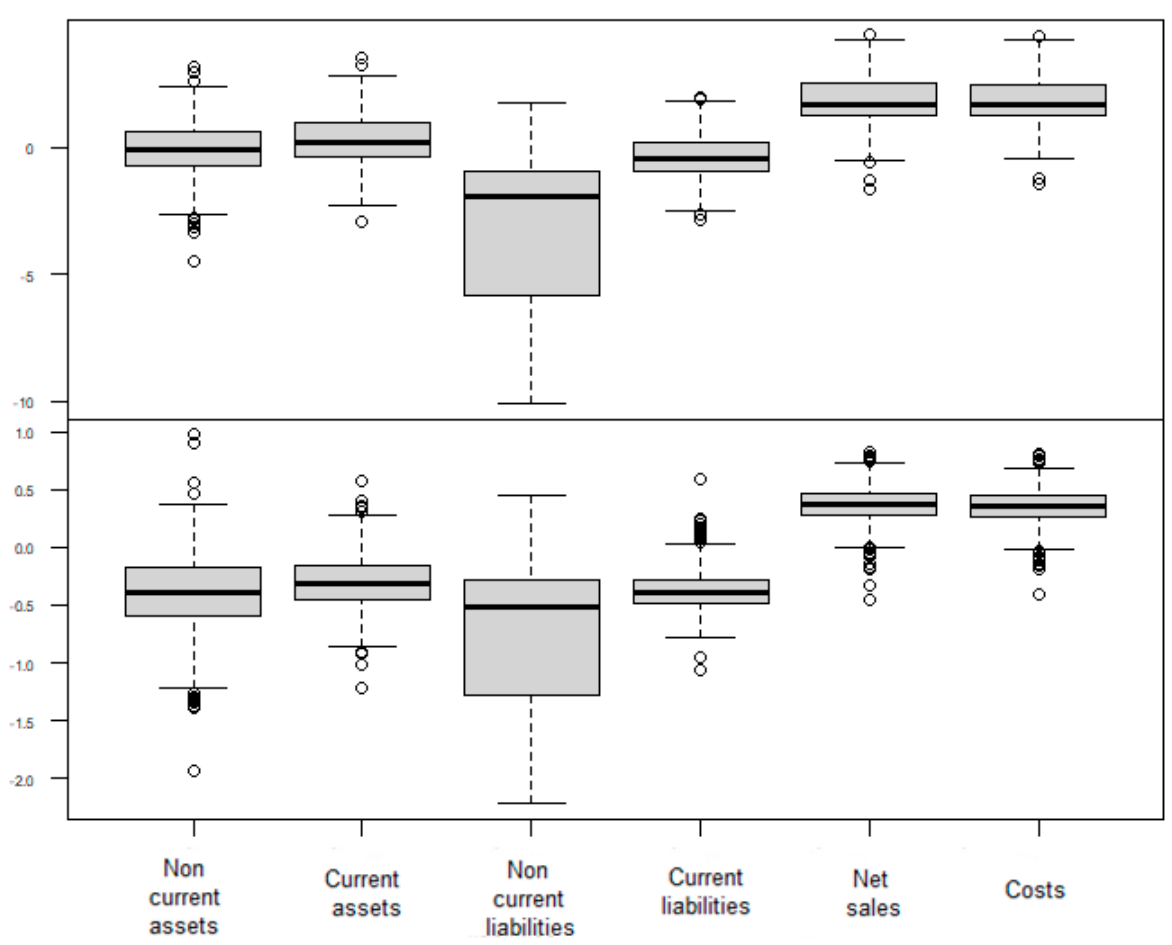
Figure 2. Boxplots of financial statements transformed as CLR ( top ) and WCLR ( bottom ) labelled according to the accounting figure in the numerator.